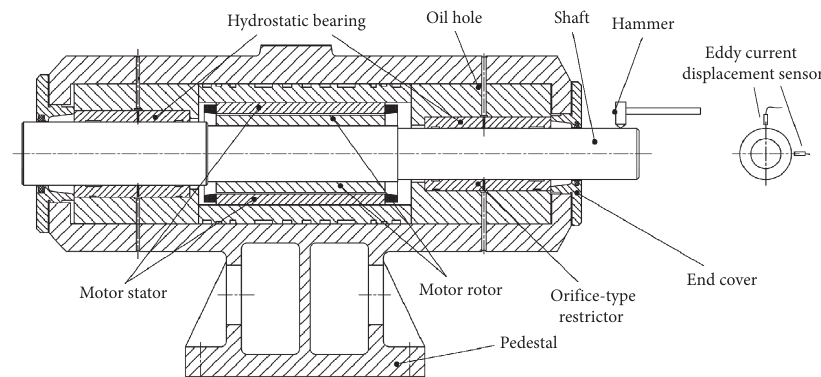
Figure 5: Testing scheme of spindle system stiffness by the hammering method.